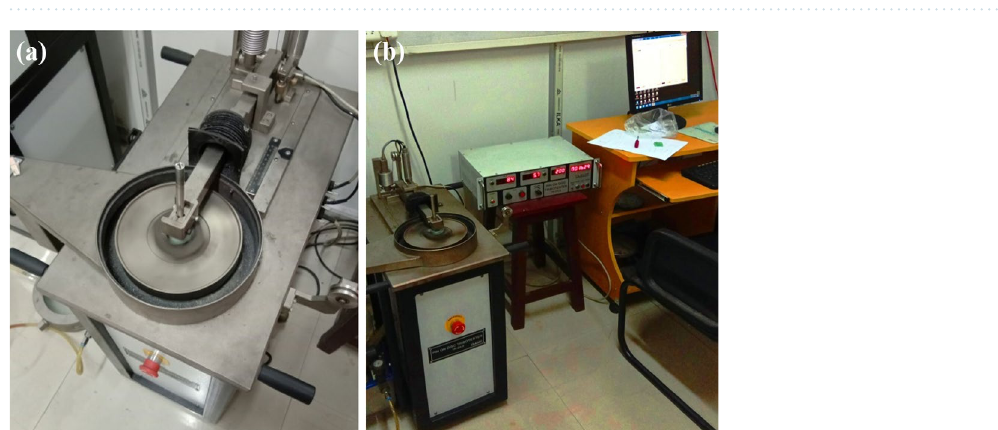
Figure 10. Wear test ( a ) sliding disc, ( b ) pin on disc